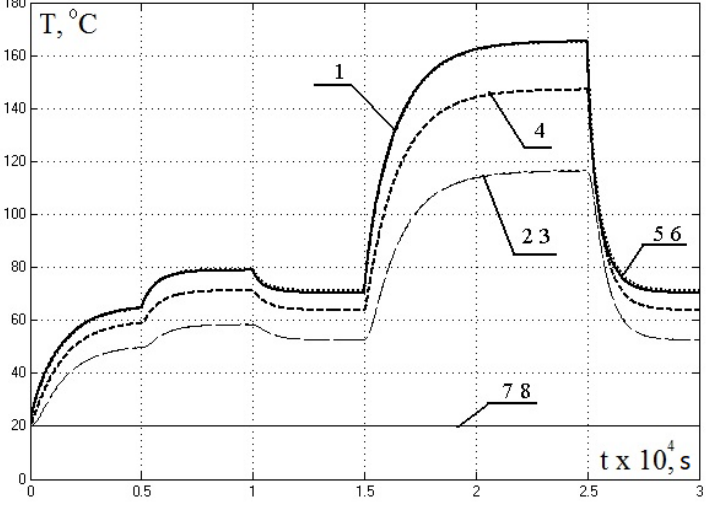
Figure 9. Temperatures on the 6-th tooth pitch: 1—slot part of primary winding; 2—primary magnetic core part above slot; 3—primary magnetic core part above tooth; 4—tooth; 5, 6—front parts of primary winding; 7—secondary conductive plate; 8—secondary magnetic core.